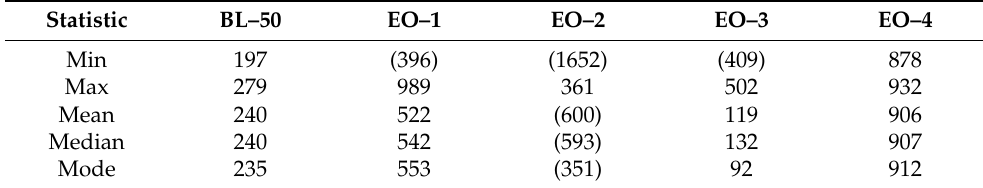
Figure 9. Stochastic NPV distribution of expansion option EO–4. Table 8. Basic statistics of the stochastic NPV distribution for all configurations (Million USD).